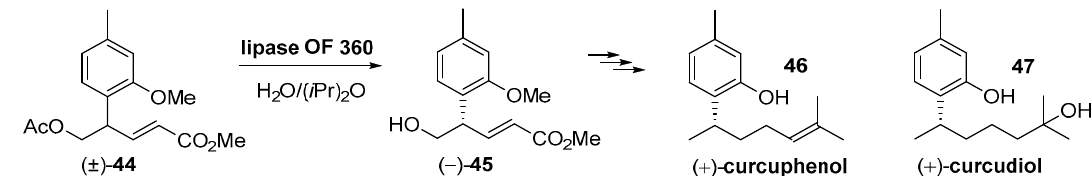
Figure 9. Lipase-mediated resolution of 5-acetoxy-4-aryl-(2 E )-pentenoate derivatives. Regio- and stereoselective hydrolysis of the primary alcohol esters. Chiral building blocks ( − )- 45 , prepared by resolution of racemic acetate 44 , was used for the synthesis of the bisabolane sesquiterpene (+)- curcuphenol ( 46 ) and (+)-curcudiol ( 47 ).